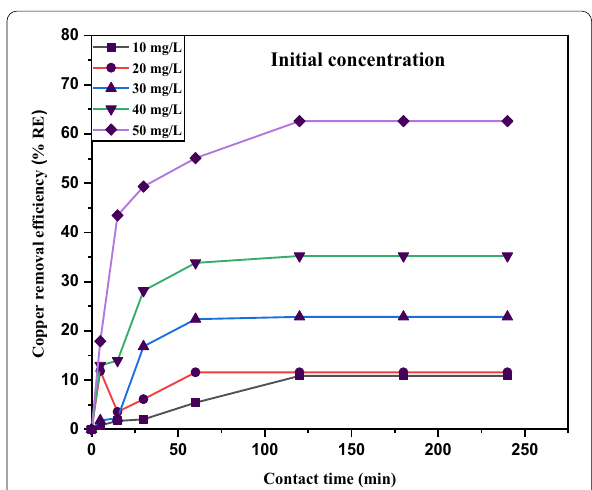
Fig. 11 Copper removal efficiency under various initial concentration of MNA-7 h (metal solution: 200 mL; temperature: 25 °C; initial pH: 5.4; adsorbent dosage: 0.05 g)